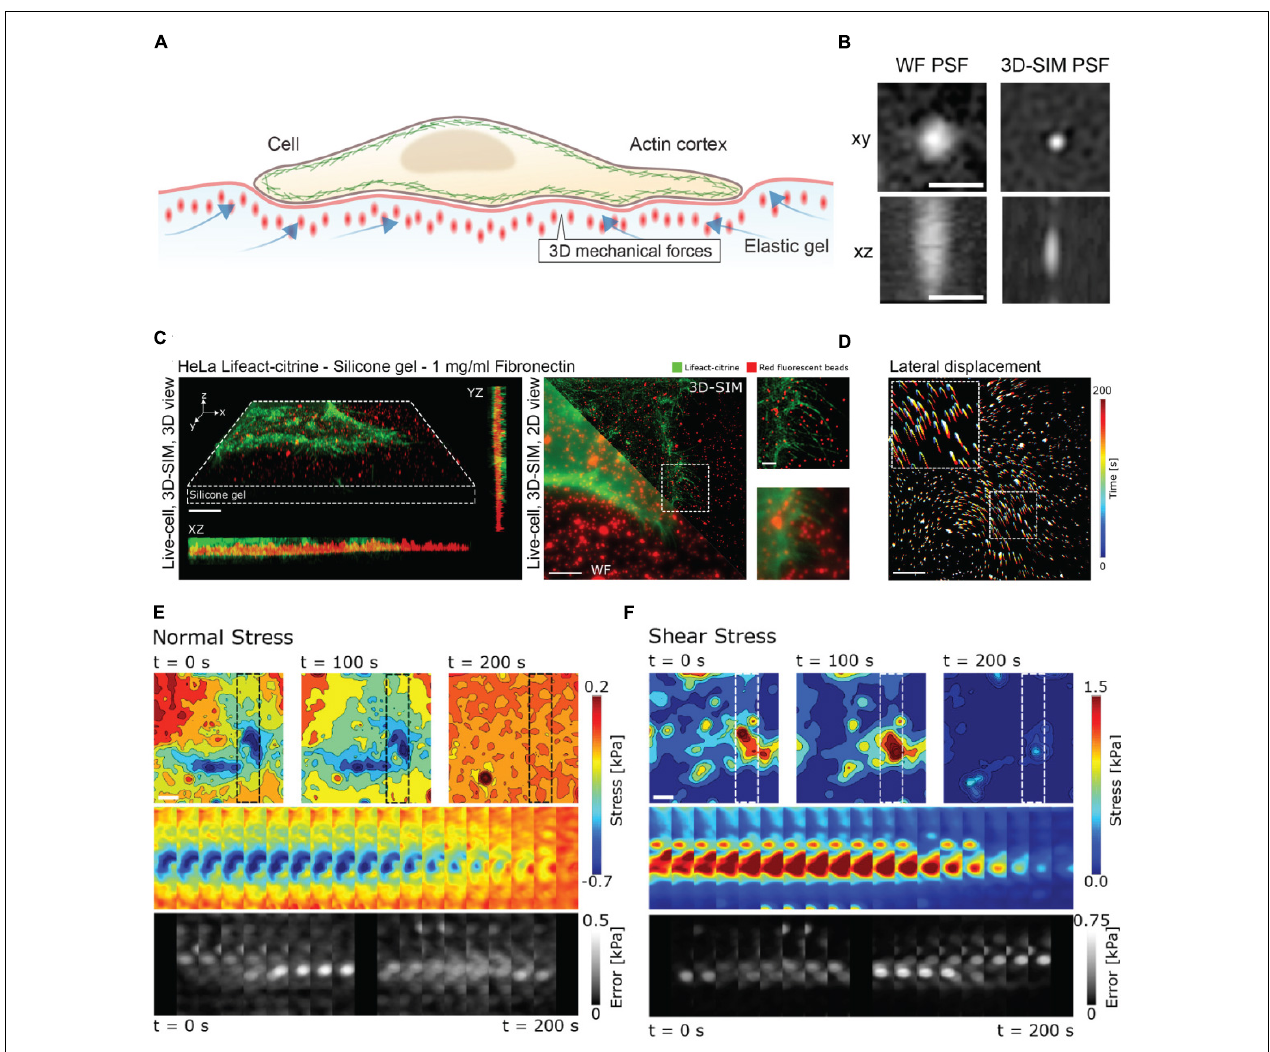
FIGURE 3 | 3D-SIM improves resolution and precision in measuring lateral and axial forces in TFM. (A) Schematic representation of 3D-TFM. (B) A comparison of PSFs demonstrates the enhanced resolution of 3D-SIM as compared to widefield (WF) microscopy. Scale bar: 0.5 µ m. (C) (Left) Volumetric rendering and axial projections of 3D-SIM images of a HeLa cell expressing Lifeact-citrine (green) on a TFM substrate with fluorescent fiducial markers (red). (Right) A comparison of WF and 3D-SIM highlights the enhanced resolution. The dashed box inset for both WF and 3D-SIM is shown for direct comparison. Scale bar: 5 µ m. (D) 2D translation of fiducial markers is shown color-coded for time, demonstrating dynamic cell-generated forces. Scale bar: 5 µ m. (E) Normal and (F) shear stress fields from a 3D-SIM-TFM experiment. Top panels show the stress fields at different points in time. Middle panels show the full time series of stress maps for the region of interest shown in the upper panels indicated by dashed boxes. The lower panels show the estimated error for each time point. Scale bar: 5 µ m. Images are reproduced with permission from Colin-York et al.